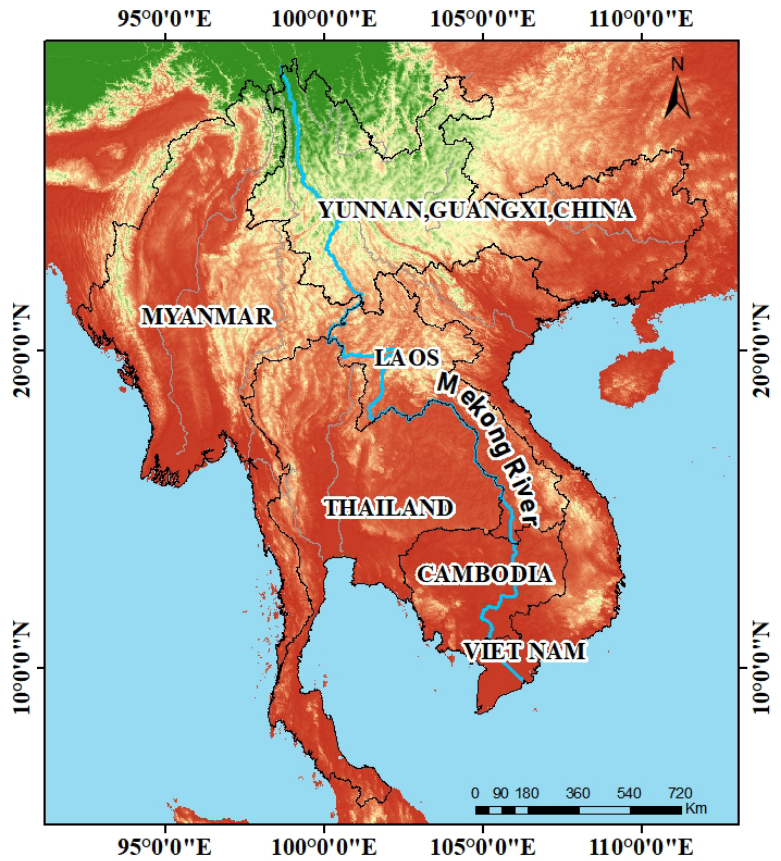
Figure 1. Distribution maps of Myanmar (MM), Laos (LA), Thailand (TH), Cambodia (KH), Vietnam (VN) and Guangxi and Yunnan provinces of China (CN) in the study area.